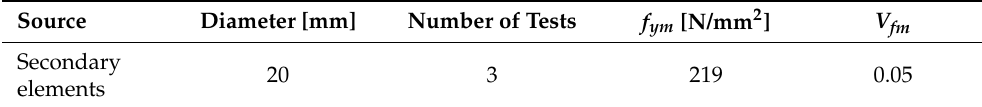
Table 2. First stage sample parameters for reinforcing steel yield strength.